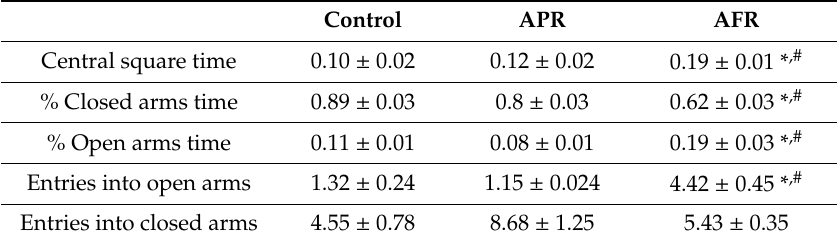
Table 1. Behavioral performance of AFR and APR rats in elevated plus maze test.